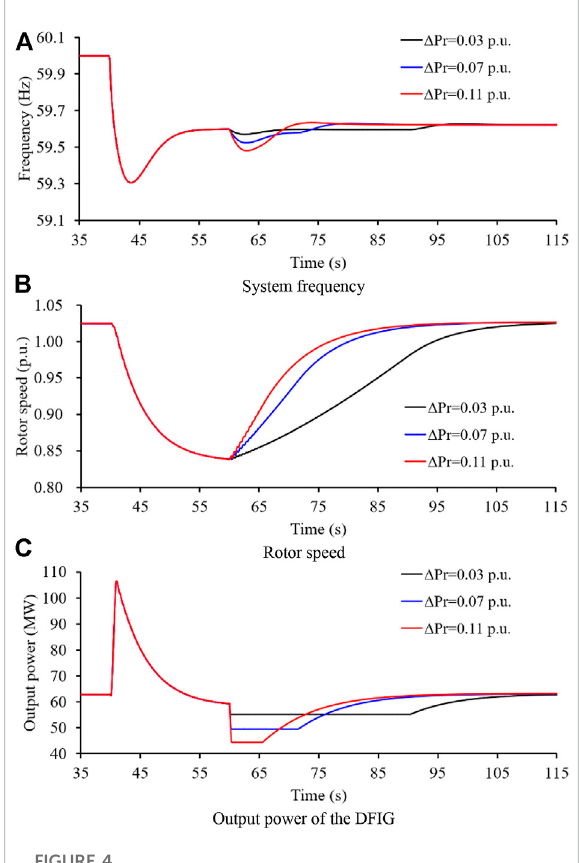
Figure3.Toavoidthestalling oftherotorspeed, thepowerreference